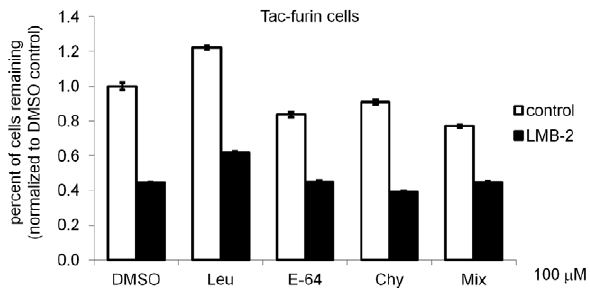
Figure 6. Effect of lysosomal protease inhibitors on LMB-2 cytotoxicity. Tac-furin cells were pretreated with 100 m M Leupeptin (Leu), E-64, Chymostatin (Chy), a combination of all three inhibitors or DMSO control for 24 hours. Cells were subsequently treated with 1 ng/ ml LMB-2 in the continued presence of inhibitors. After a 24 hour incubation with immunotoxin, cells were counted using the Hoechst- based assay. The number of cells remaining after toxin treatment is shown as a fraction of cells incubated without toxin normalized to the DMSO control (n=6 wells). The standard error of the mean is shown. Similar experiments were performed twice and one representative data set is shown.